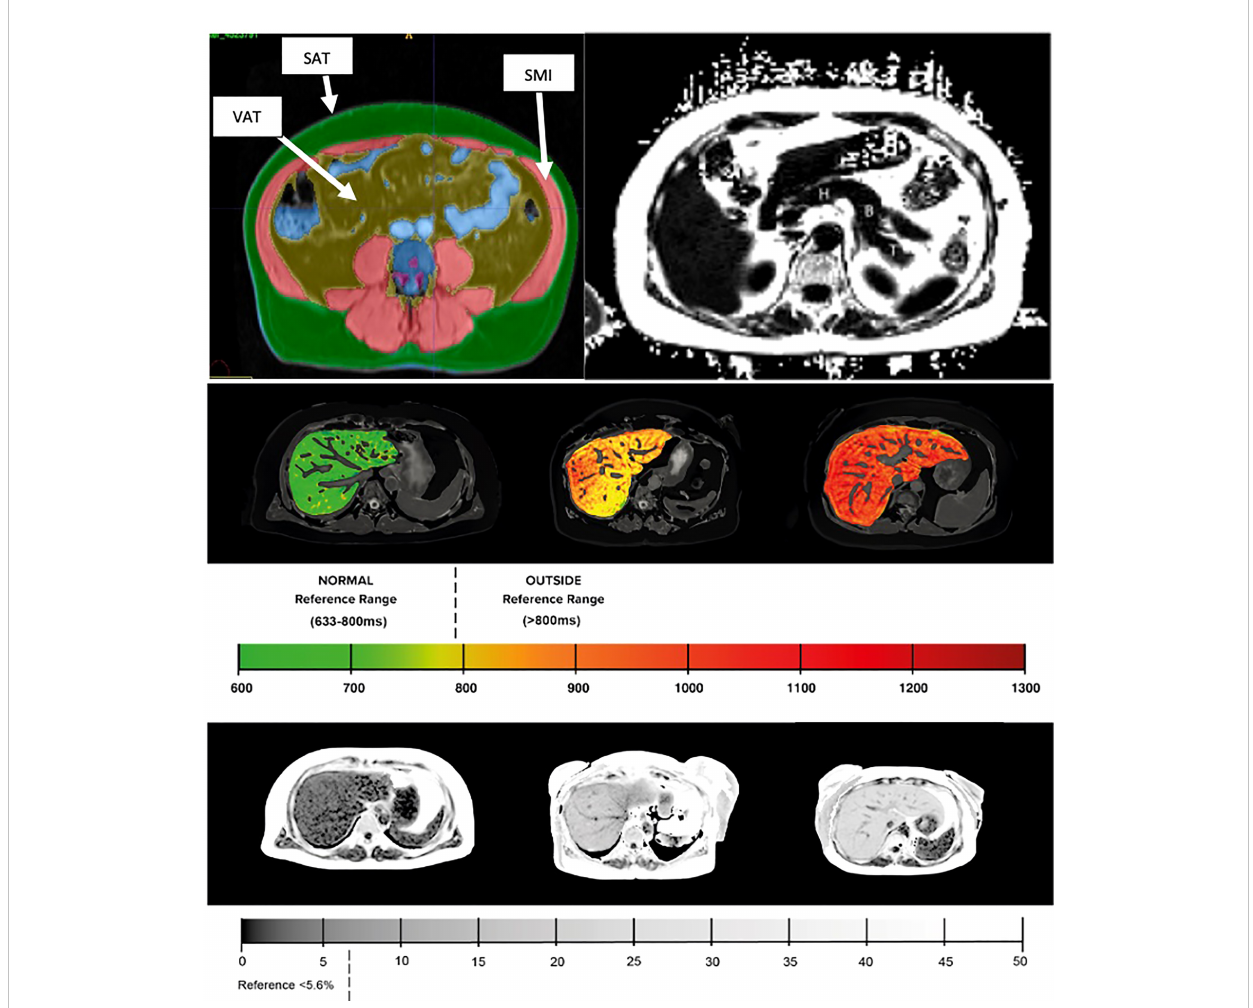
FIGURE 1 (Top left) Example MR images of body composition segmentation: SMI, skeletal muscle index; SAT, subcutaneous adipose tissue; VAT, visceral adipose tissue. (Top right) pancreas with example typical ROI placement (H – head, B – body, T – tail). (Middle) liver cT1 and (bottom) liver PDFF with corresponding reference